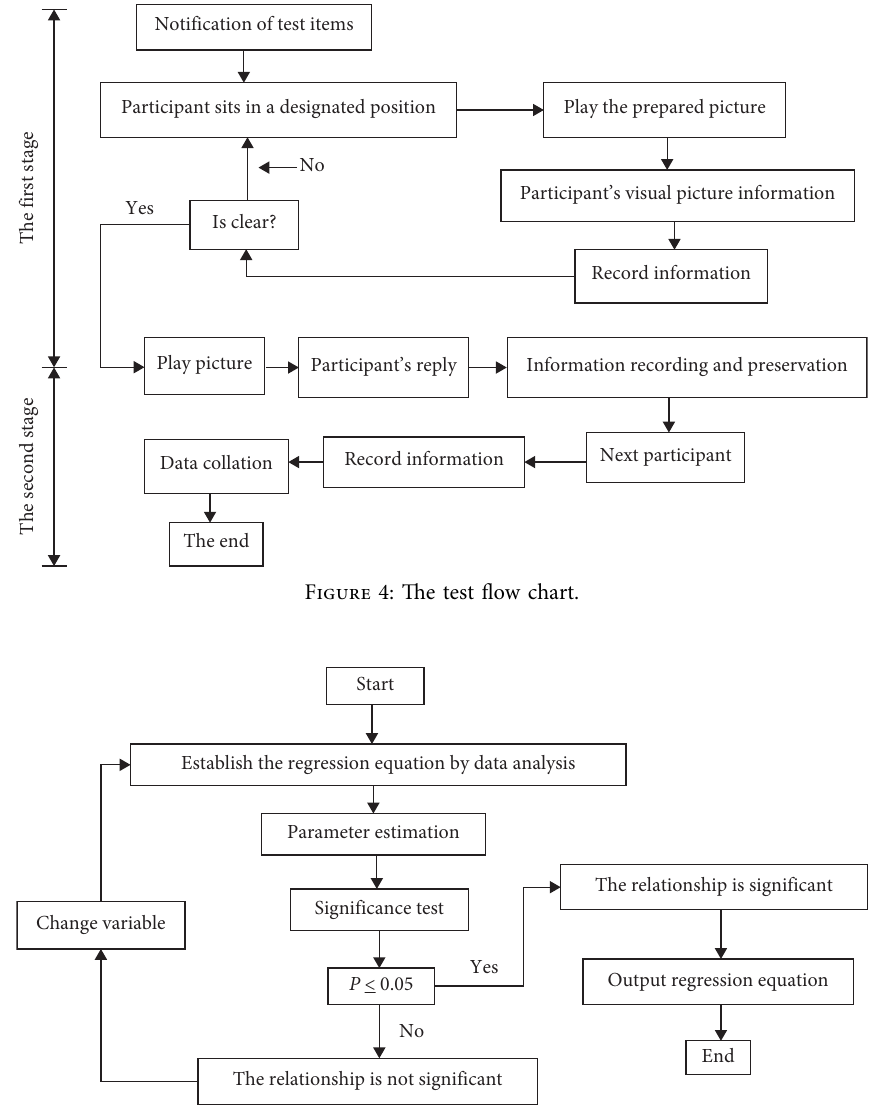
Figure 4: The test flow chart.